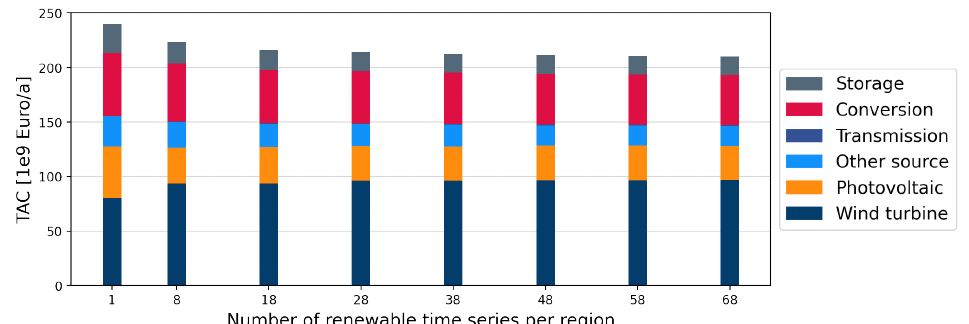
Figure 11. TAC obtained for different technologies in the case of 96 regions, when different numbers of aggregated VRES times series per region are considered.